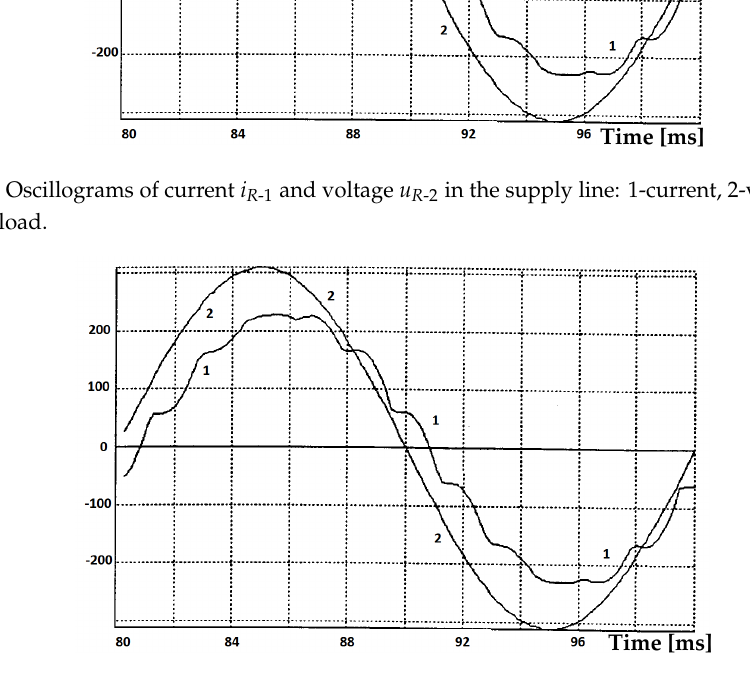
Figure 11. Oscillograms of current i R-2 and voltage u R-1 in the supply line: 1 – current, 2 - voltage at rated converter load.